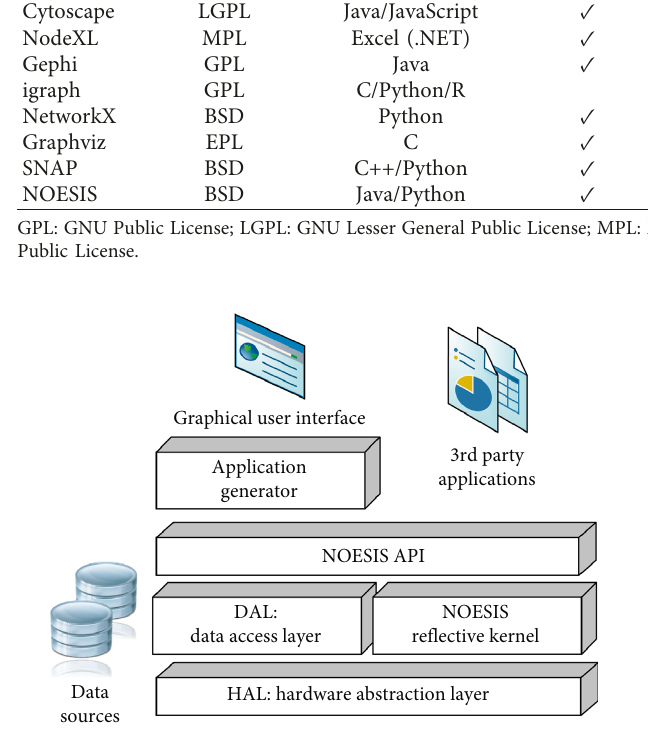
Figure 1: NOESIS framework architecture and its core